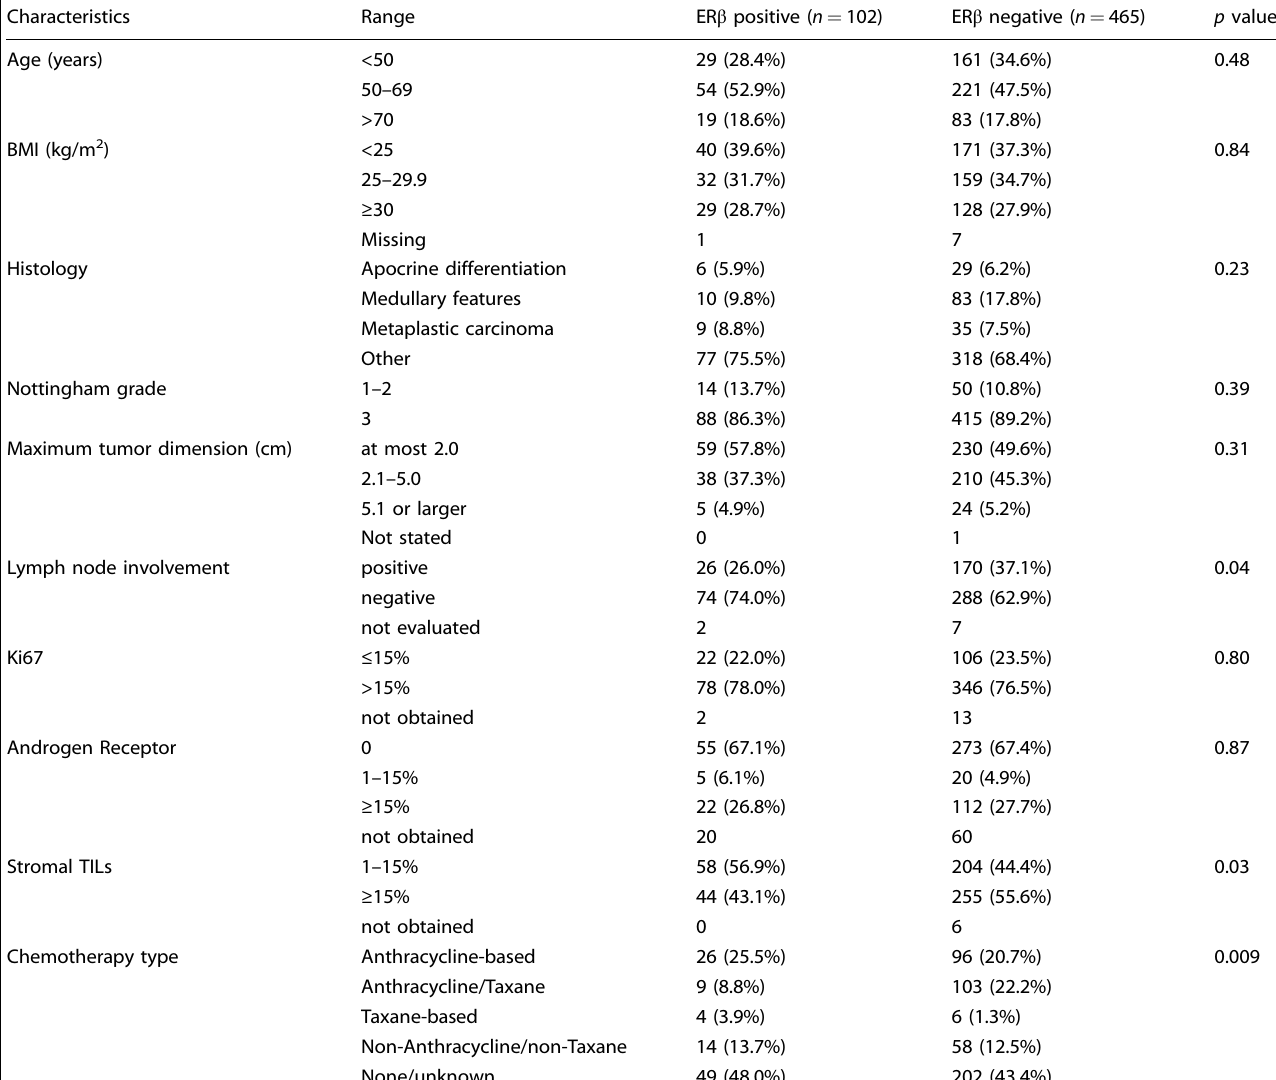
Table 1. Mayo clinic TNBC cohort characteristics strati fi ed by ER β expression.